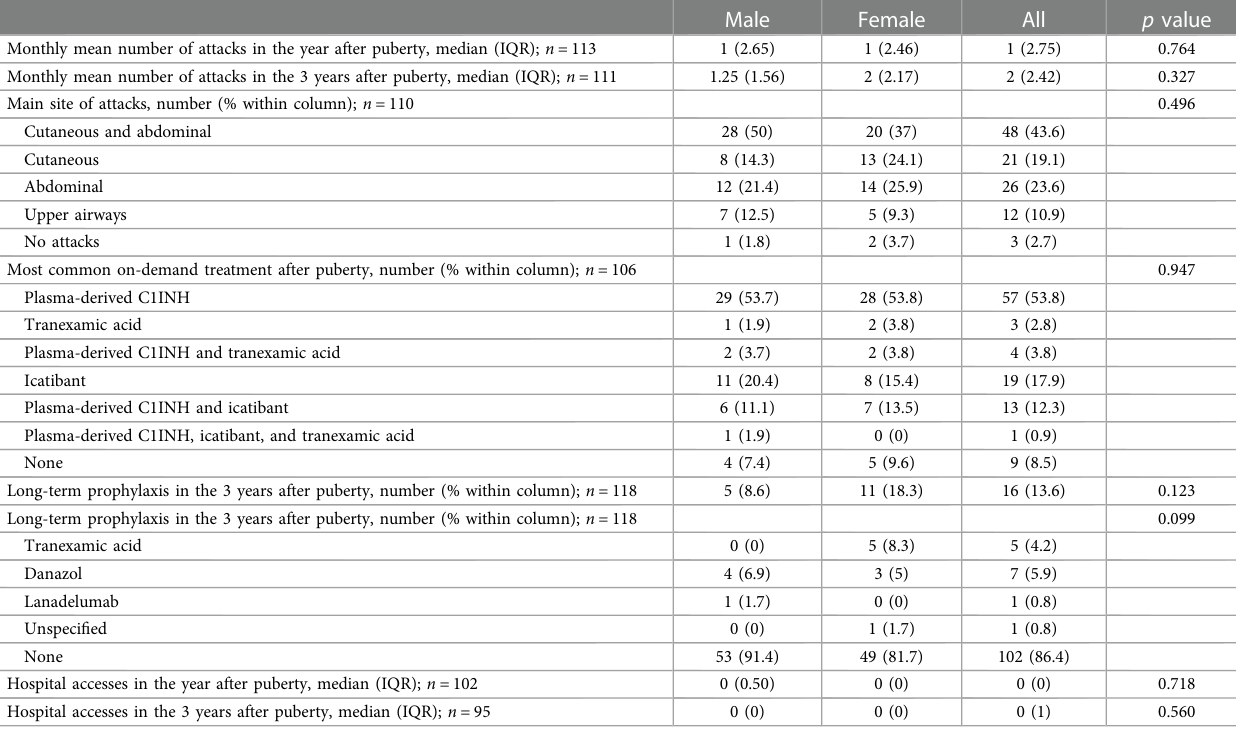
Male Female All p